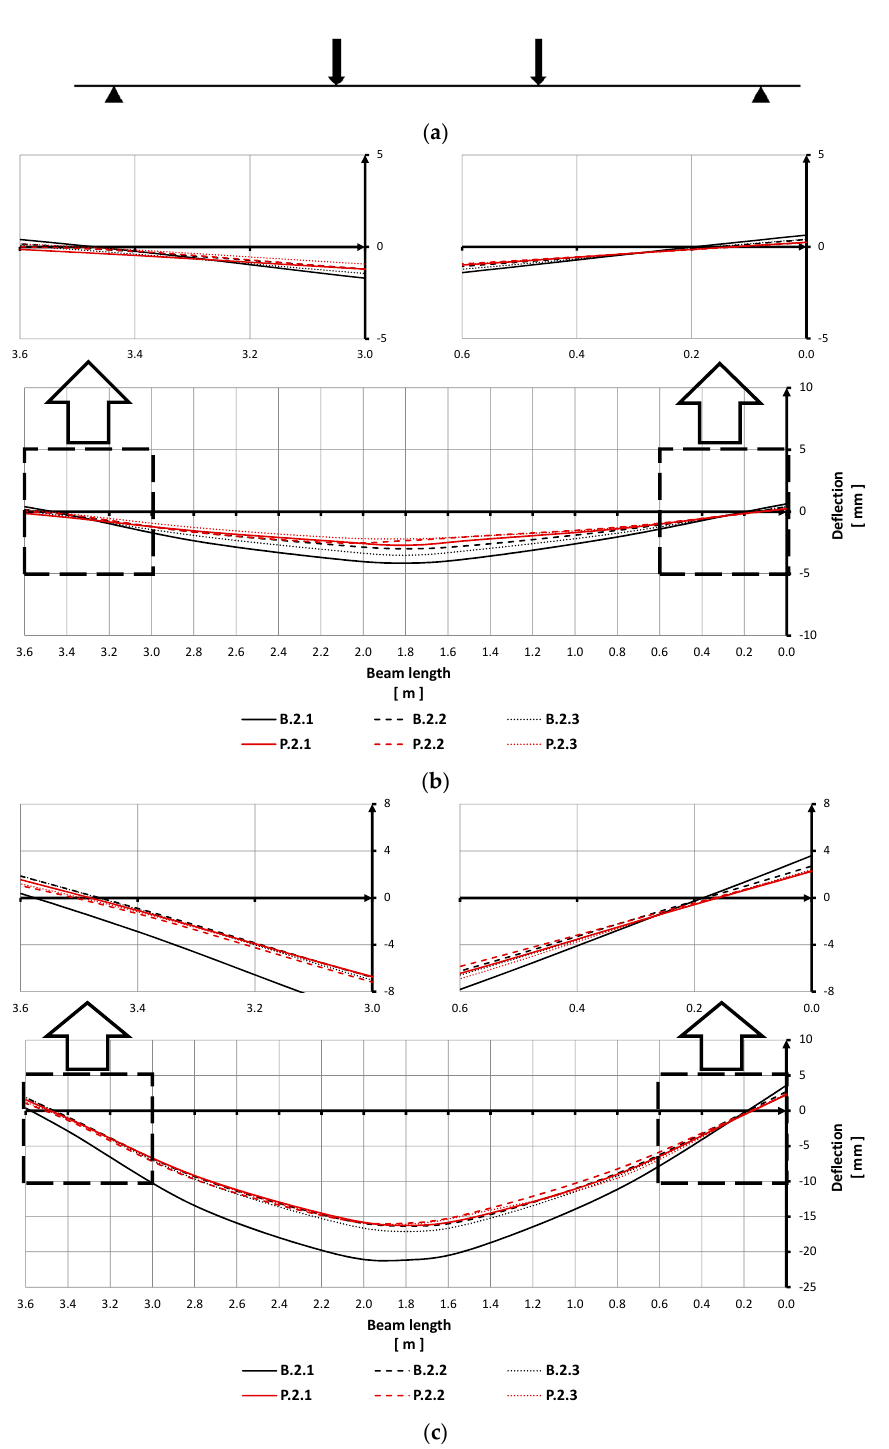
Figure 10. Beam displacements along the specimen under loads equal to 20% and 80% of the breaking force: ( a ) Arrangement of load exerted on the beam; ( b ) beam displacement under load equal to 20% of the breaking force; ( c ) beam displacement under load equal to 80% of the breaking